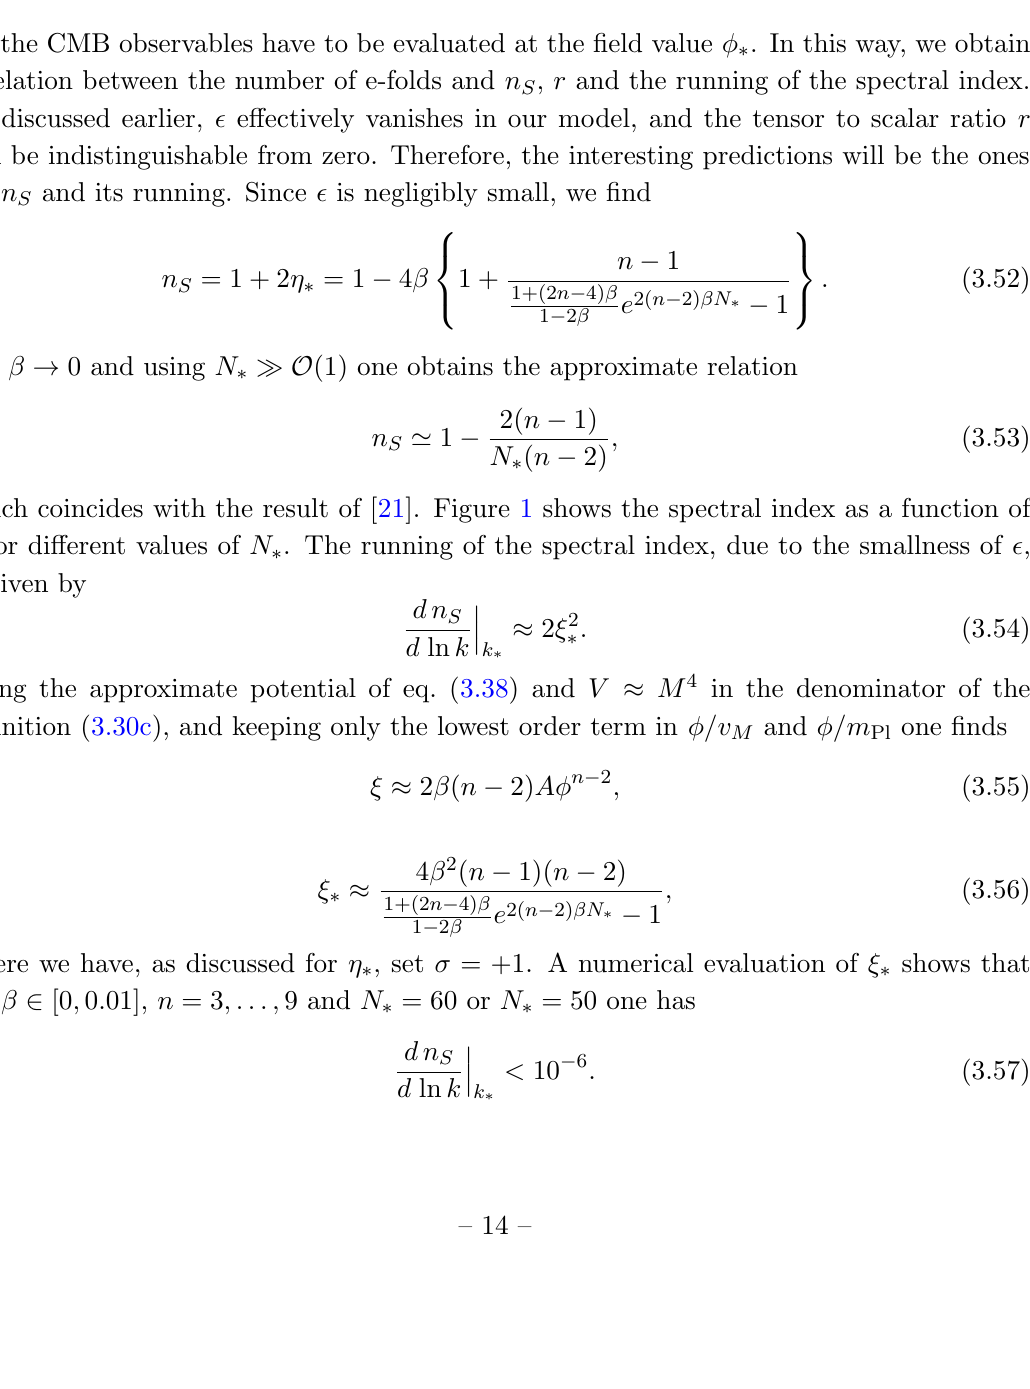
Figure 1 . The spectral index of our model as a function of (cid:12) for di(cid:11)erent values of n (lowest line: n = 3, uppermost line: n = 9). The purple and gray bands are the 68% and 95% C.L. intervals for n S as determined by the Planck Collaboration in [44] (Planck TT +lowP +BKP +lensing +ext). Left: N (cid:3) = 60, Right: N (cid:3) =